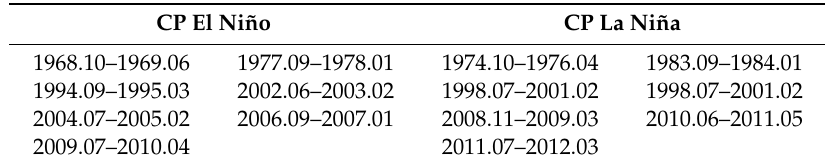
Table 1. The starting and ending month of central Pacific El Niño–Southern Oscillation (CP ENSO) events during the years 1961 to 2016.